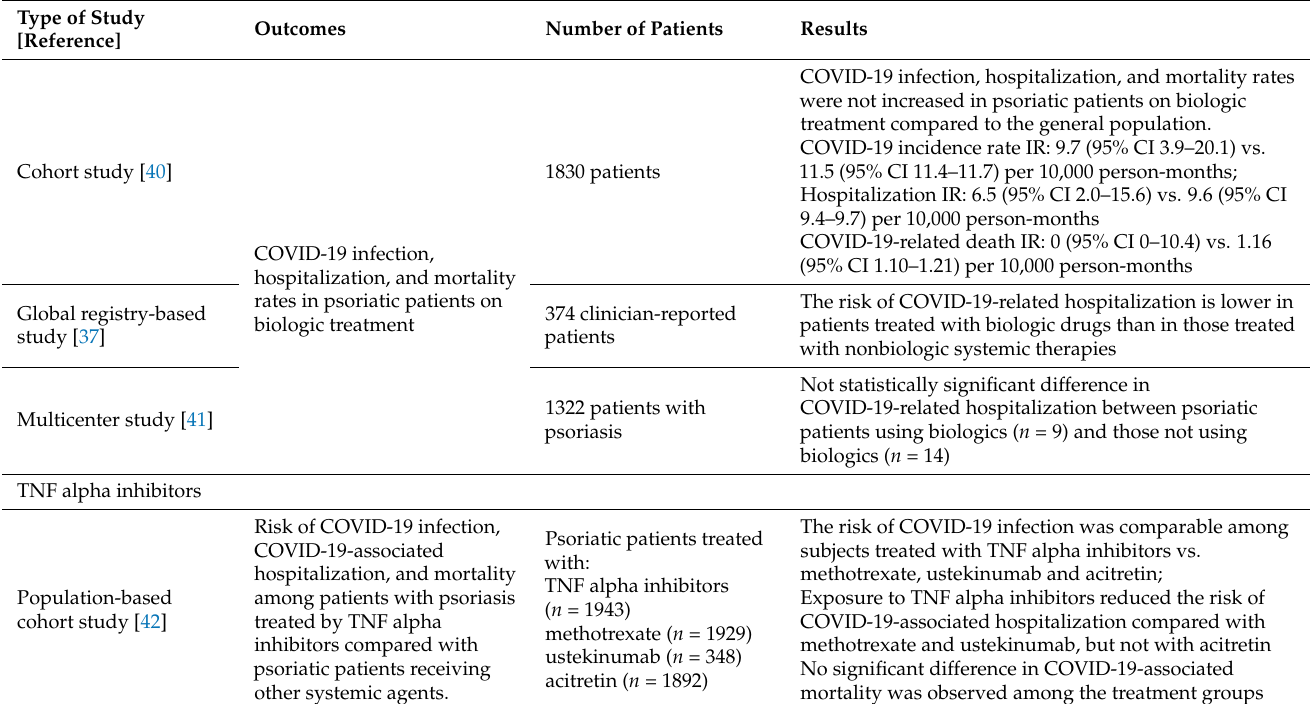
Table 3. Impact of SARS-CoV-2 infection on systemic treatments in psoriatic